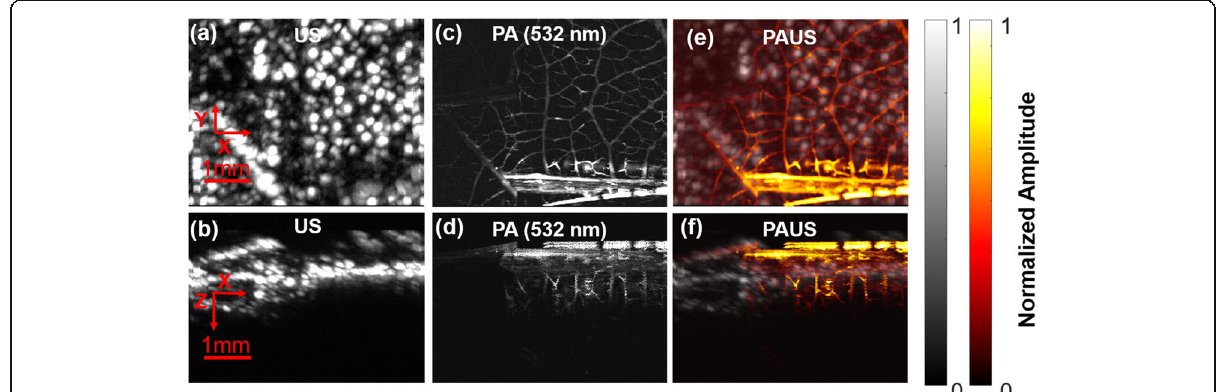
Fig. 4 Dual-transducer PAUS of a leaf phantom. Phantom leaf results obtained by an alternative PAUS system with two single-element focused ultrasonic transducers, showing the XY and XZ projections for US ( a , b ), PA ( c , d ), and fused PAUS ( e , f ). The FOV for the XY plane is 5 × 4 mm 2 , and the left part is the green leaf and the right part is the red leaf